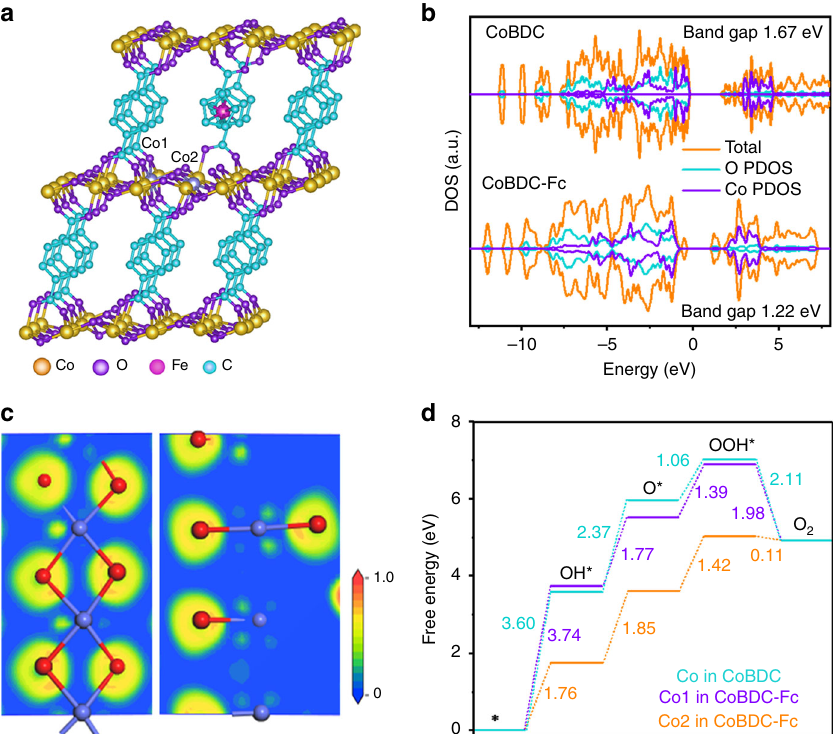
Fig. 2 DFT calculations on improving OER performance of MOFs. a Crystal structure of CoBDC-Fc obtained from DFT simulation. b Calculated DOS of CoBDC and CoBDC-Fc. c Electron localization function of CoBDC-Fc. d Free energy diagram for OER on CoBDC and CoBDC-Fc